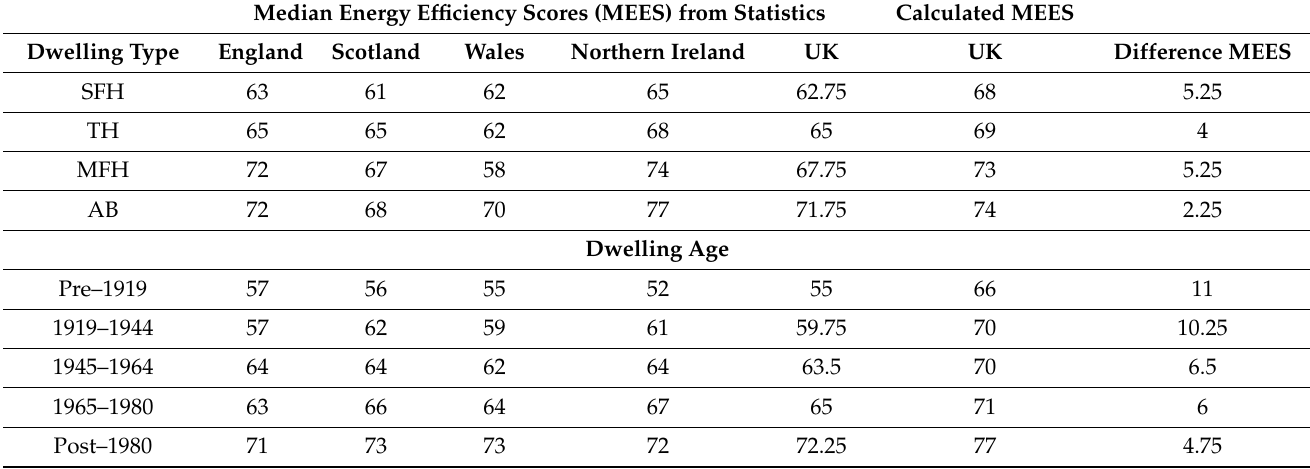
Table 1. Comparison of median SAP rating from statistics and calculated median SAP